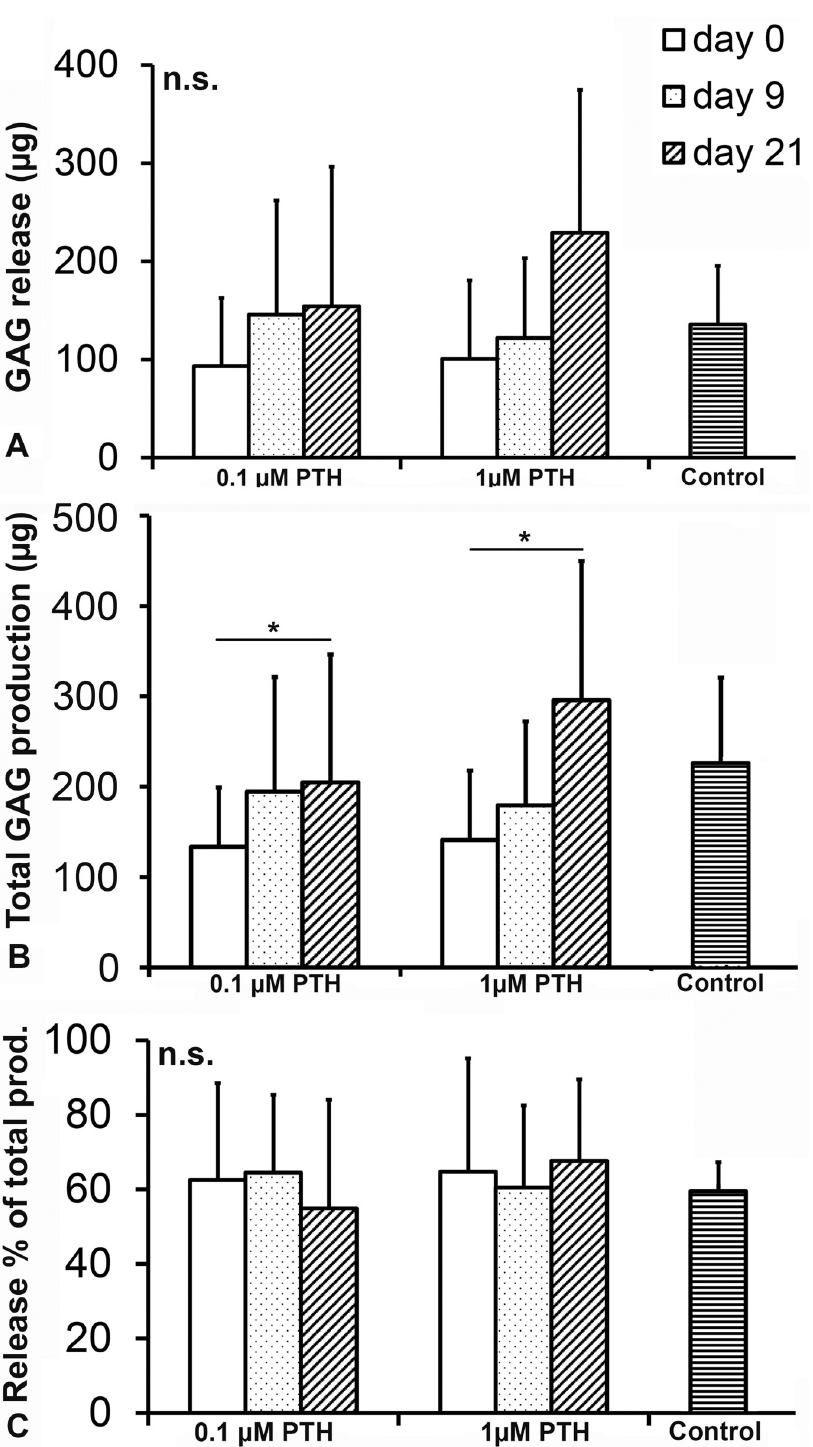
Fig 5. Total GAG production, total GAG release and GAG release as percentage of total production of human chondrocytes cultured for 28 days in the presence of 0.1 or 1.0 μ M PTH from day 0, 9 or 21 onwards. Controls did not receive PTH. Total GAG production was dependent on moment of PTH supplementation ( � : p = 0.042), but not on PTH concentration. n.s.: not significant. Graphs show mean ± 95% C-I. n =